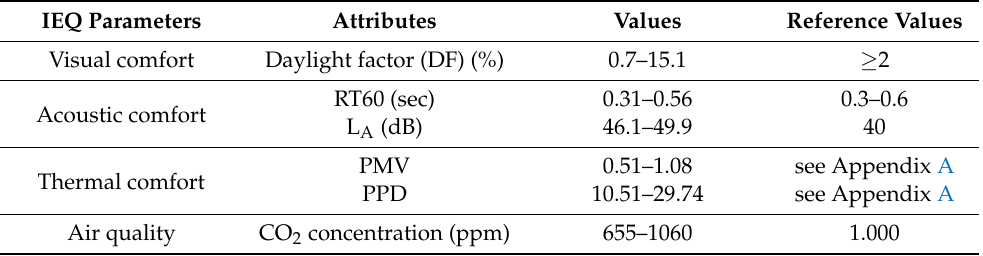
Table 4. The minimum and maximum values of the measured IEQ parameters.